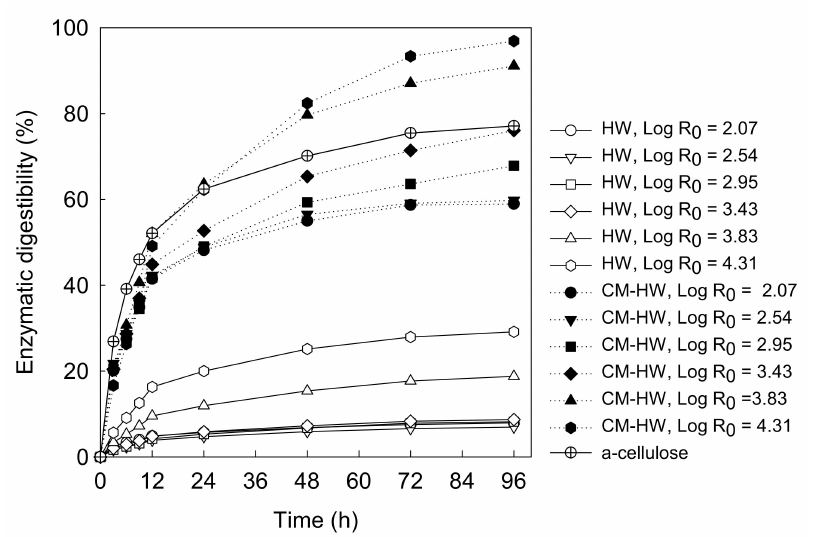
Figure 8. Enzymatic digestibility of untreated and CM-treated oak wood treated using HW with cellulase loading of 15 FPU/g glucan. Table 3. Previous study on enzymatic digestibility of oak wood using various pretreatment methods. Pretreatment Enzymatic Hydrolysis